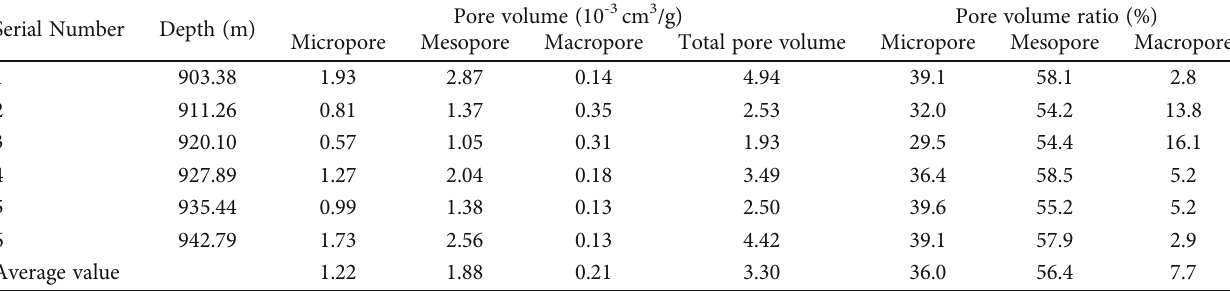
Table 1: Statistical table of the shale pore volume of the Longmaxi Formation of well